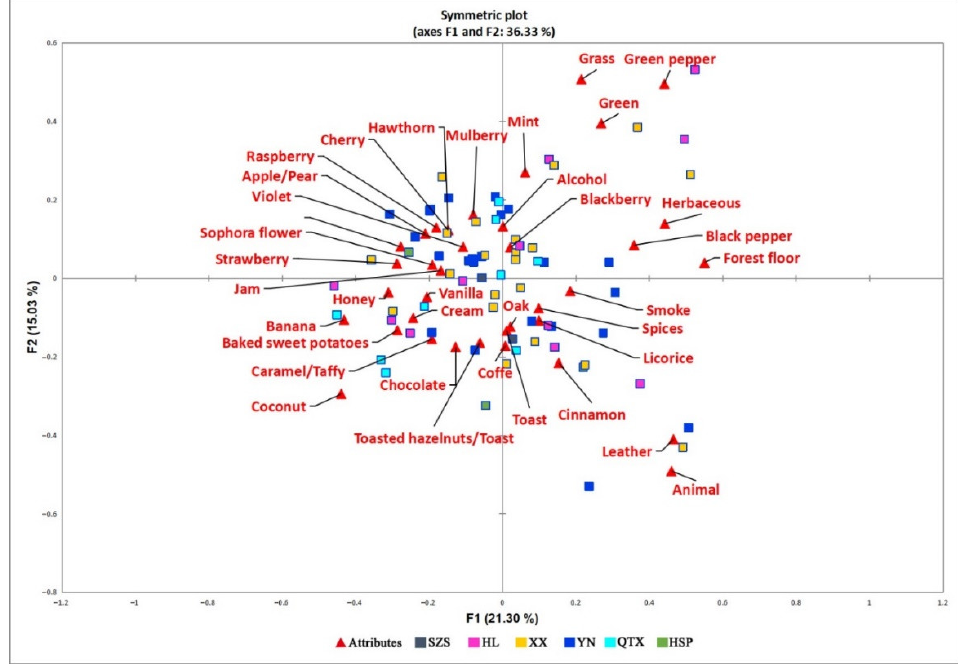
Figure 3. Correspondence analysis of ‘Cabernet Sauvignon’ dry red wines from six sub-regions of the Eastern Foothills of Helan Mountain in Ningxia. SZS, Shizuishan region; HL, Helan region; XX, Xixia region; YN, Yongning region; QTX, Qingtongxia region; HSP, Hongsipu region.